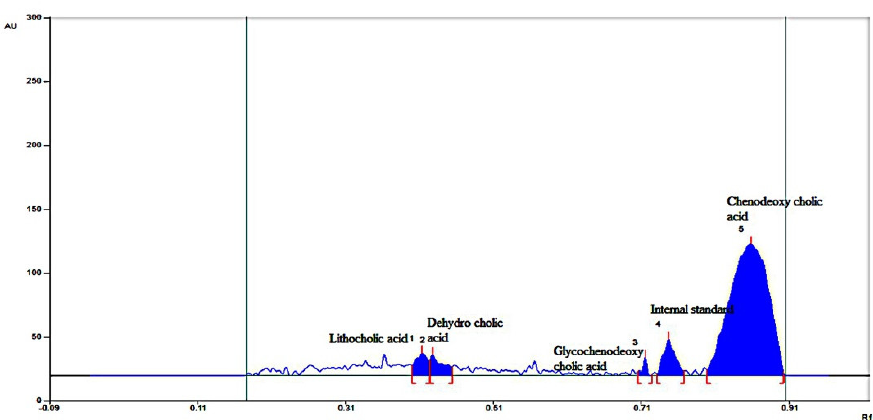
Figure 3. HPTLC analysis of bile acids present in feces of CS − SS nanofomulation − treated mice.